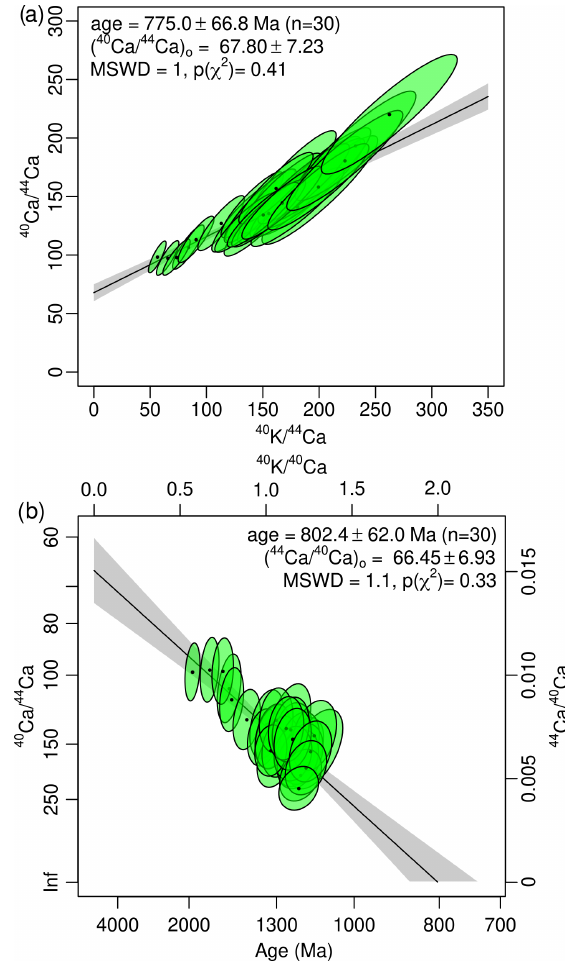
Figure 2. (a) Conventional and (b) inverse isochrons for a repre- sentative outcome of the semi-synthetic K–Ca data generator. The true age is 800Ma and the true initial 40 Ca / 44 Ca ratio is 66. The inverse isochron better approximates these values than the conven- tional isochron. Uncertainties are shown as 95% confidence inter-